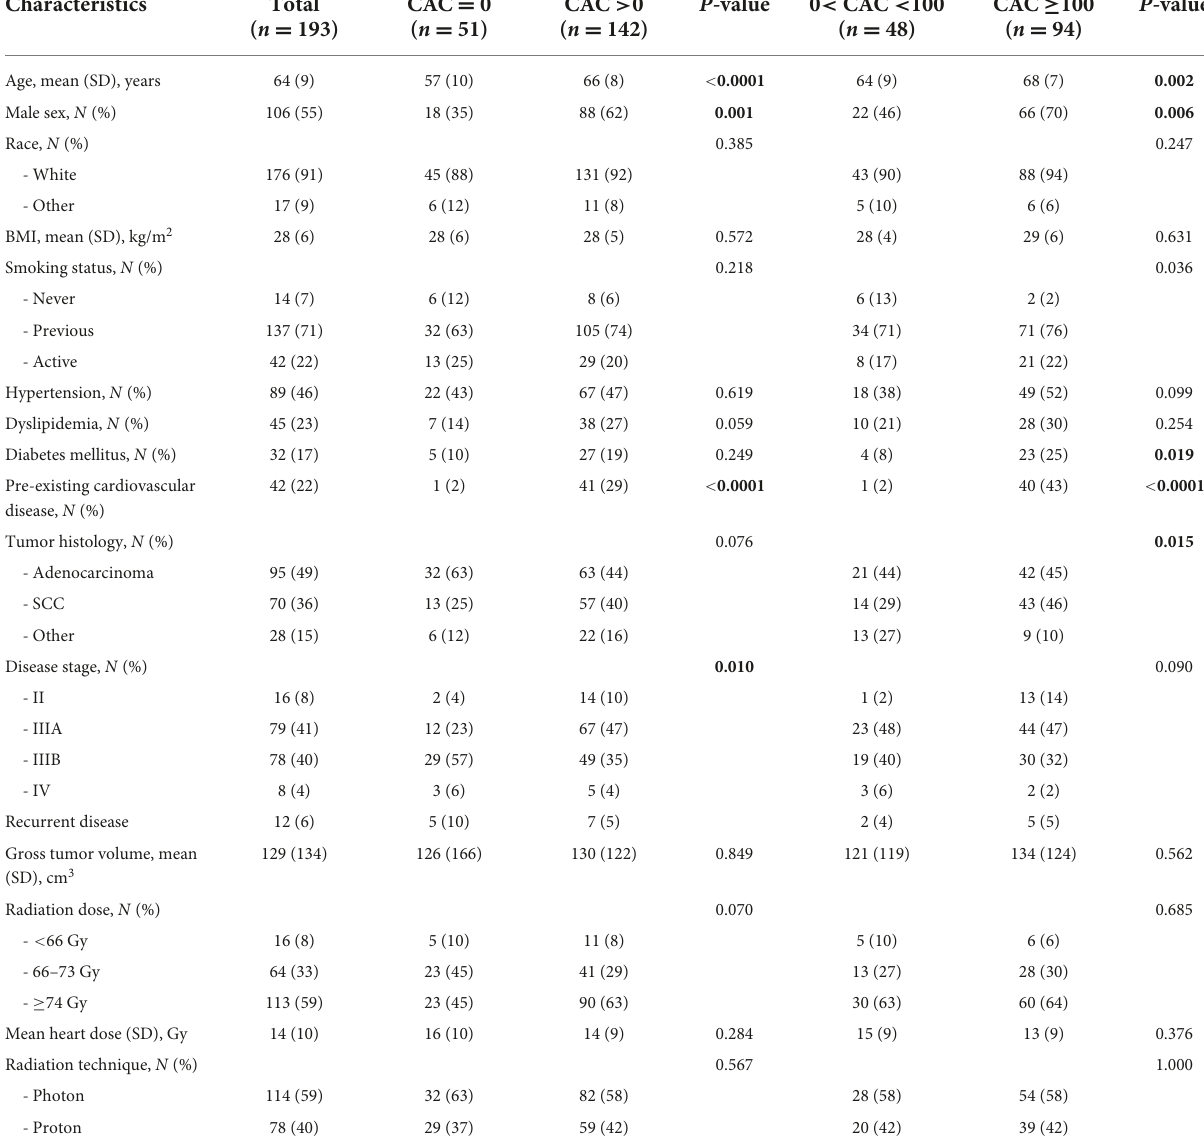
TABLE 1 Demographic and baseline clinical characteristics of 193 patients with NSCLC treated with concurrent chemoradiation categorized based on their baseline coronary calcium scores.